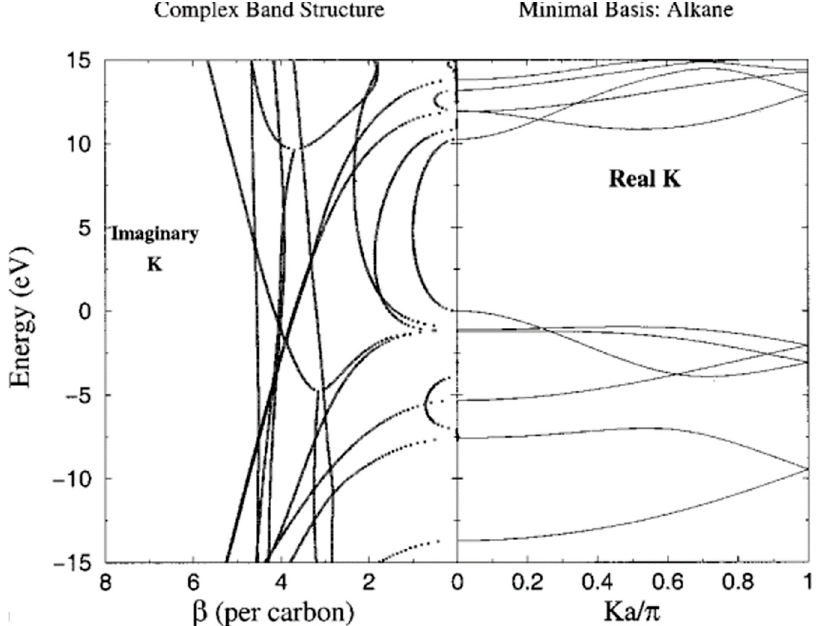
Figure 3. Calculated complex bandstructure for an infinite alkane molecular chain. The left and right part of the graph correspond to the imaginary and real wavevectors, respectively. The attenuation factor can be read on the horizontal axis, in the imaginary wavevector part, considering the localized state with the smallest extension (semielliptical-like curve). Reprinted figure from [30] and with permission. Copyright (2002) by the American Physical Society.